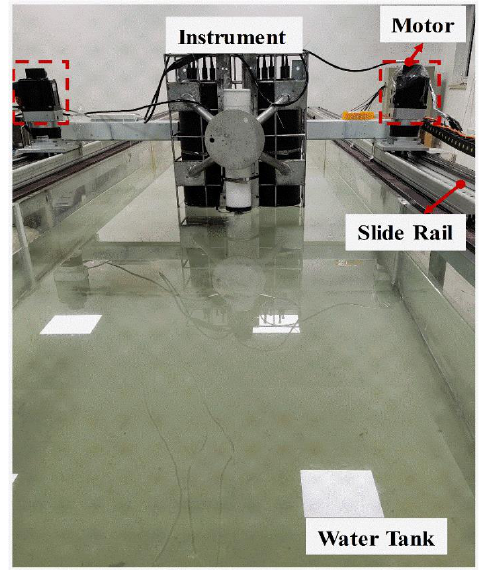
Figure 4. Motorized slide rail on the water tank for velocity calibration and measurement. Monodispersed titanium dioxide spheres (with a diameter of 50 μm, refractive index of 1.56 and density of 1.03 – 1.05) were placed in the water as particles to form a dilute colloidal suspension (1 part solid to 1 × 10 6 parts H 2 O by volume).